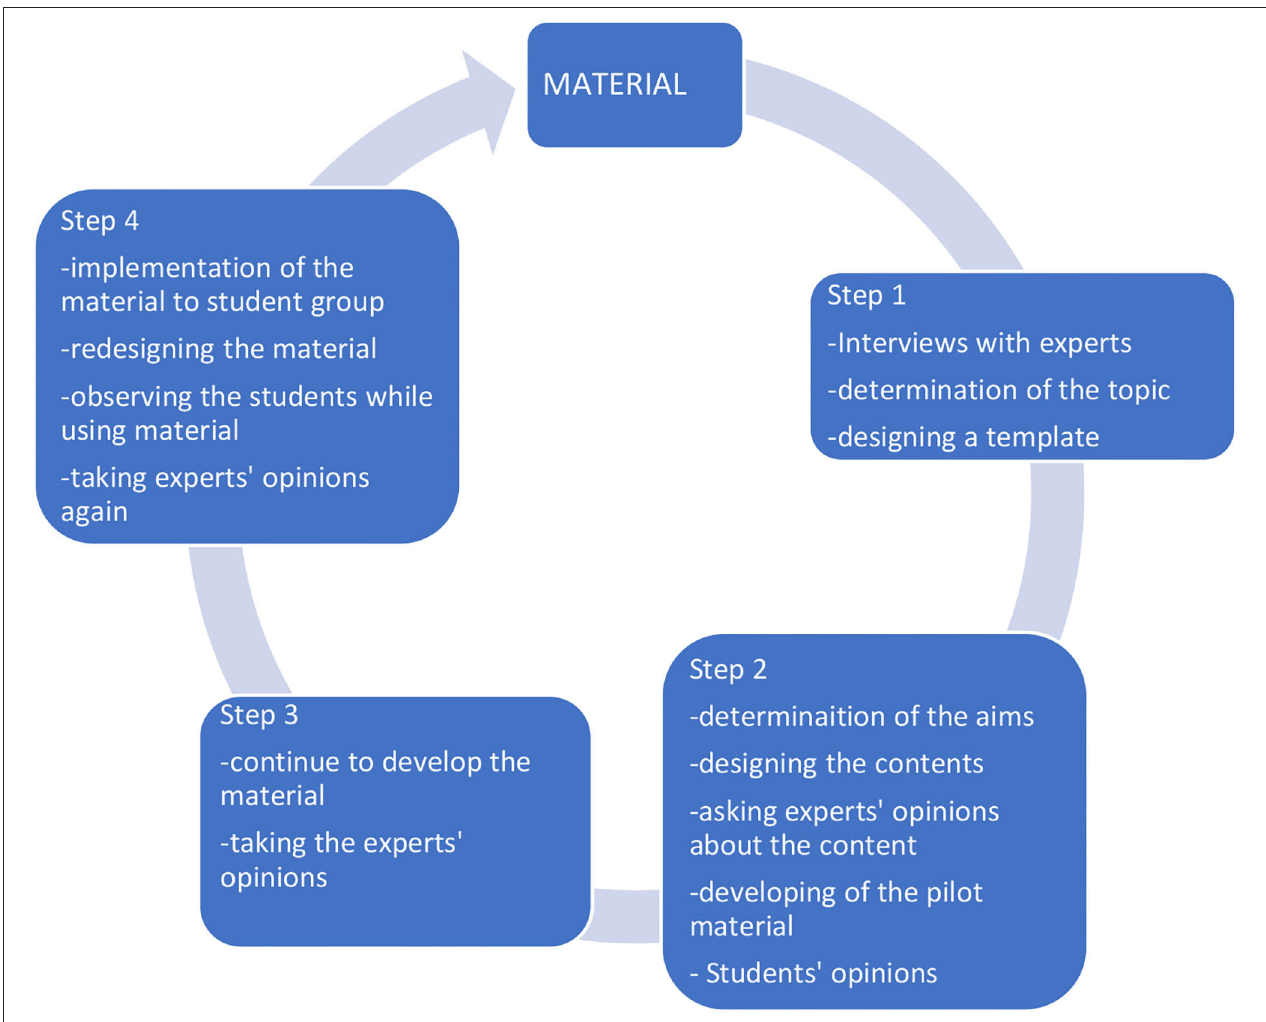
FIGURE 1 | Application development